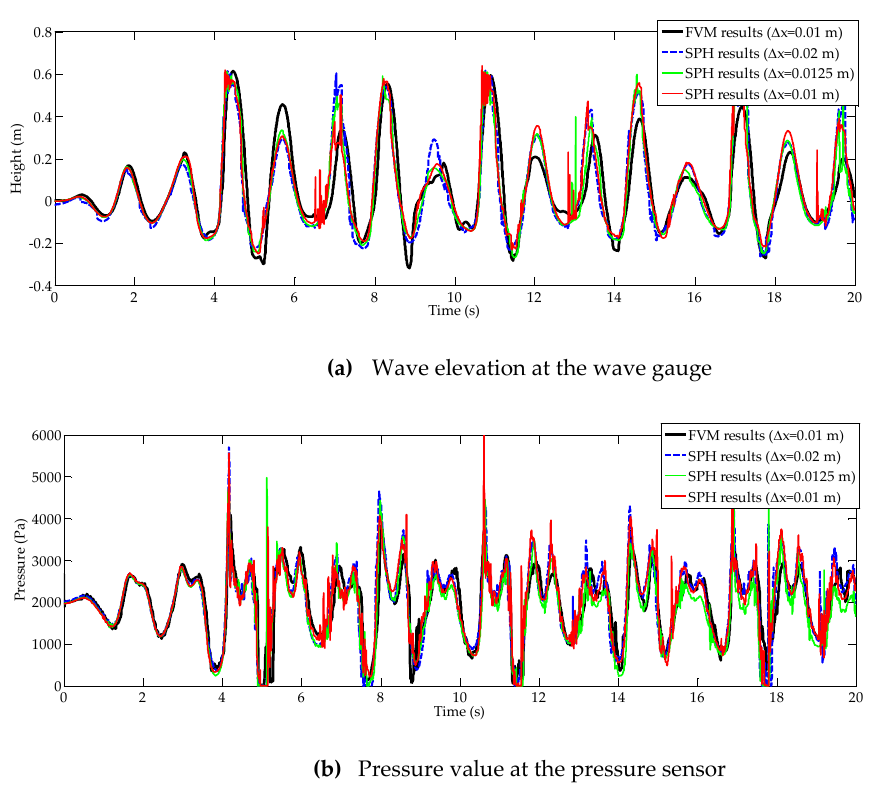
Figure 16. Numerical results obtained by FVM simulation and SPH simulations: ( a ) Wave elevation at the wave gauge; ( b ) Pressure value at the pressure sensor.